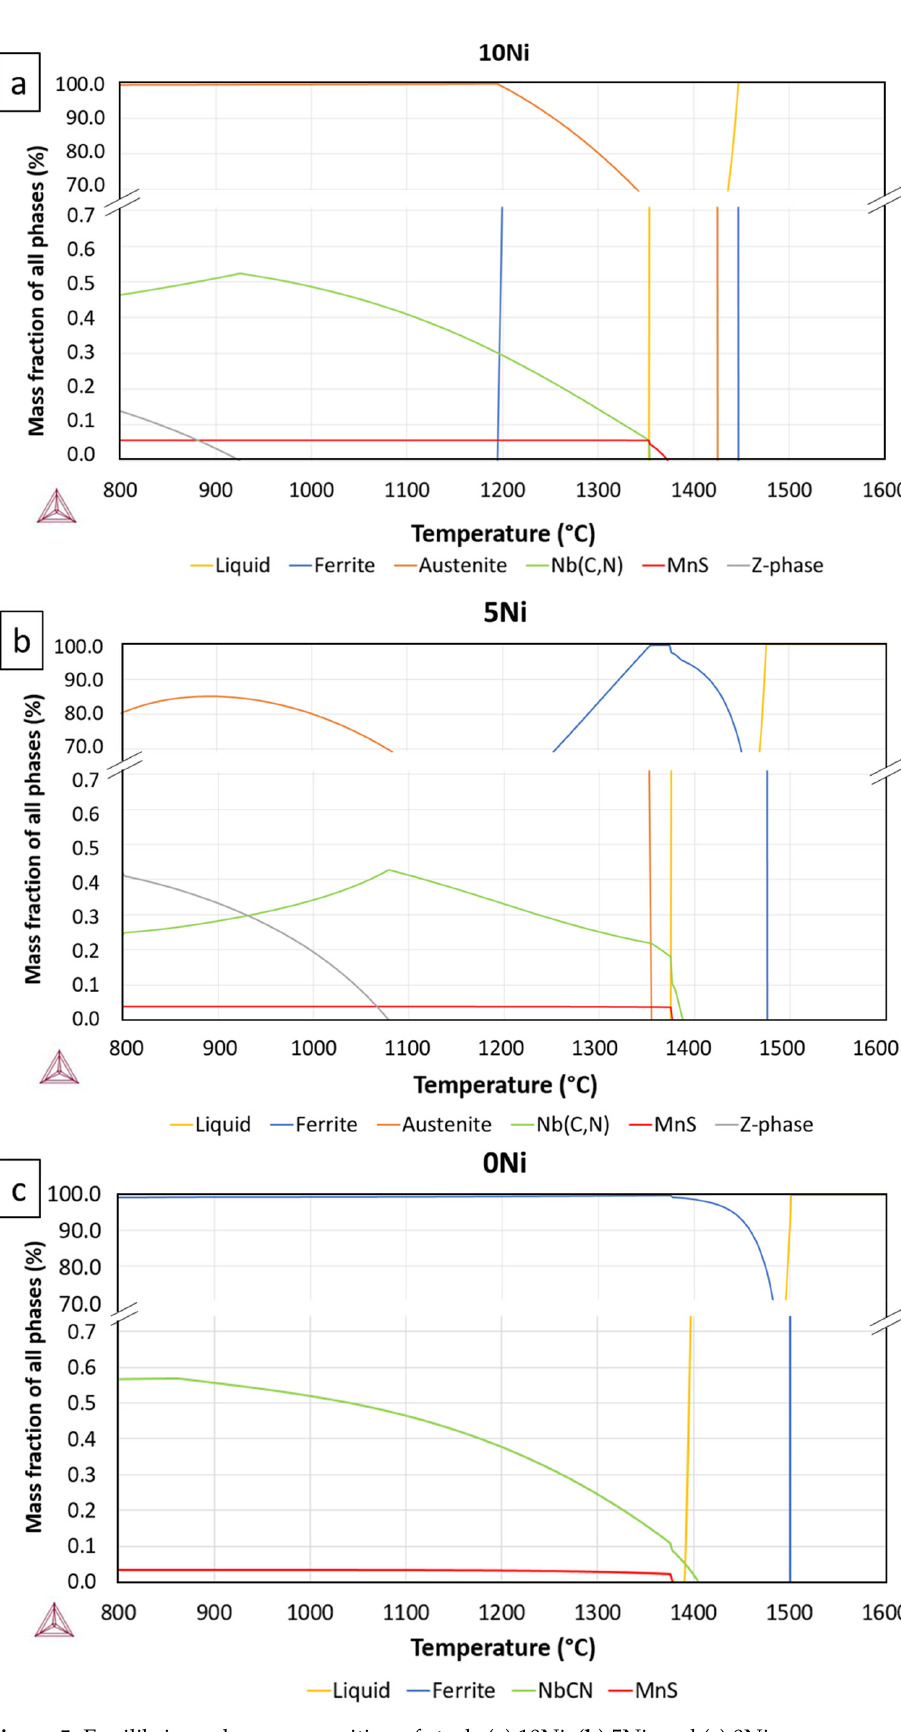
Figure 5. Equilibrium phase composition of steels ( a ) 10Ni, ( b ) 5Ni, and ( c ) 0Ni.